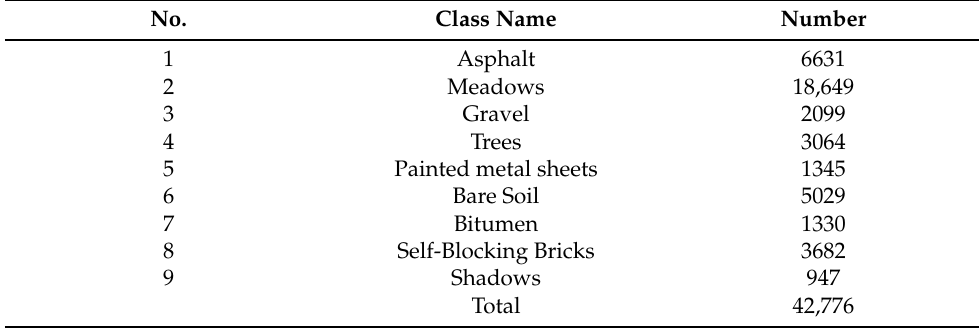
Table 2. Information on the number of samples per category in the PaviaU dataset. No.